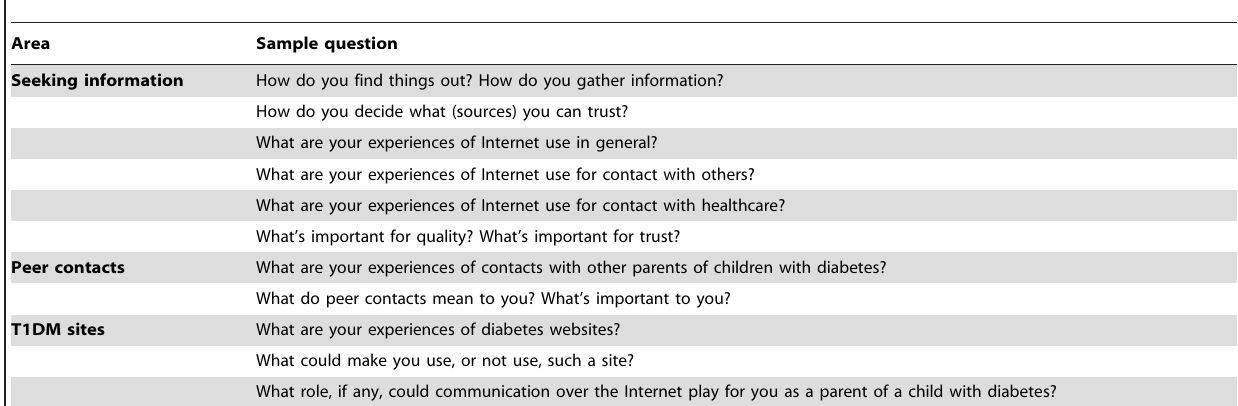
Table 2. Examples of focus group guiding questions from the interview guide.